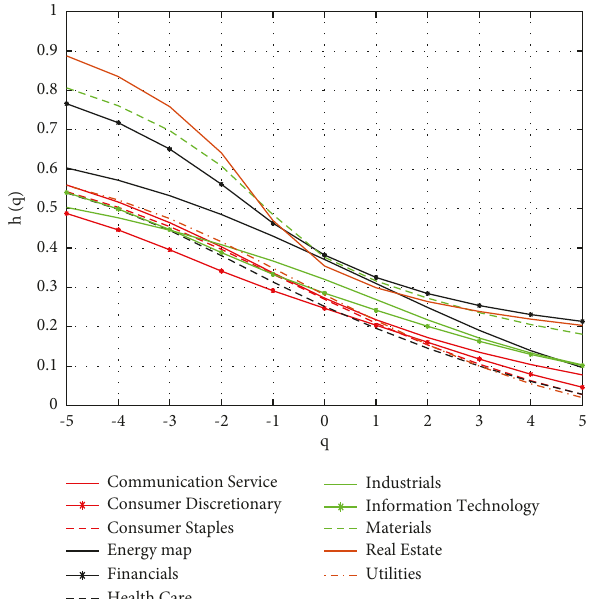
Figure 8: Generalized Hurst exponents h ( q ) of the MATV